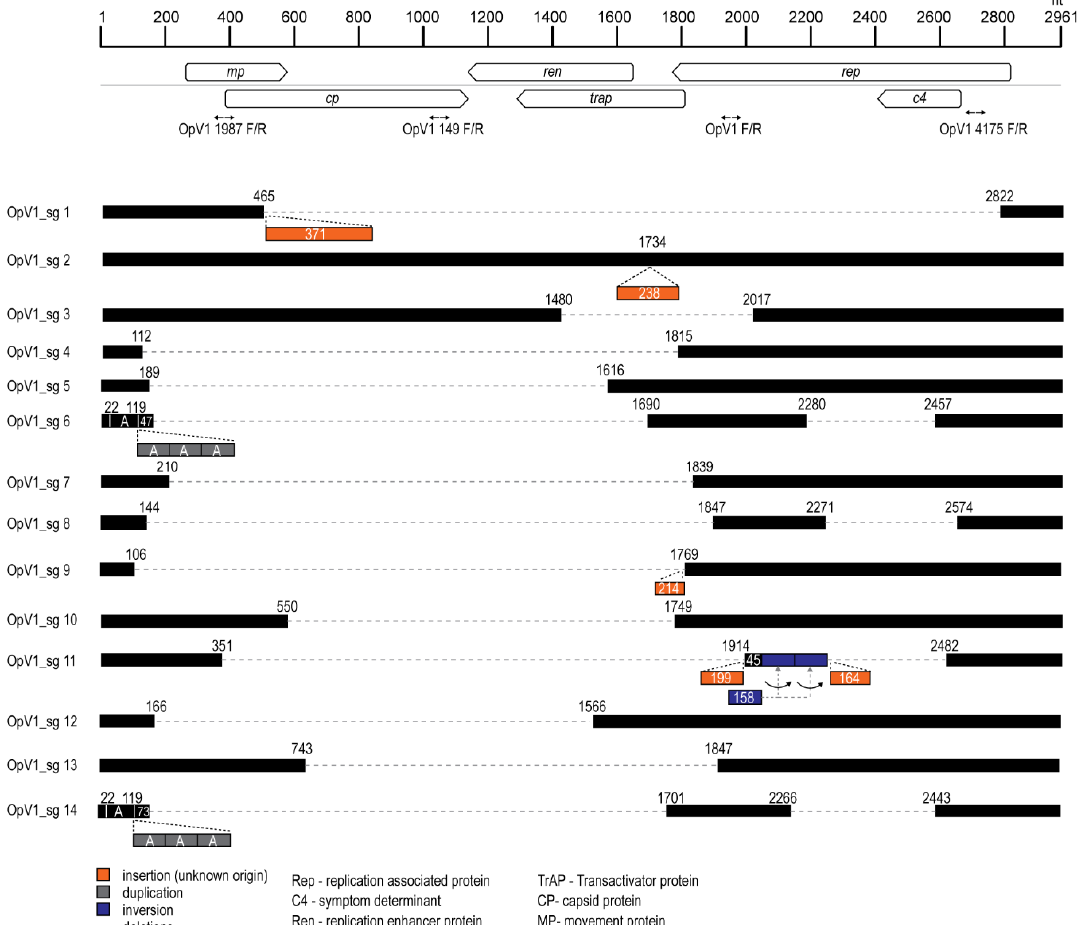
Figure 5. Structure of OpV1 sub / super-genomic molecules in comparison to an OpV1 parental full-length genome. The areas where deletion occurred are presented by dotted grey lines, insertions, inversions and duplications are represented by orange, blue and grey boxes respectively. The primers pairs used to obtain the sub/super-genomic molecules are shown at their respective binding sites on the parental full-length genome.